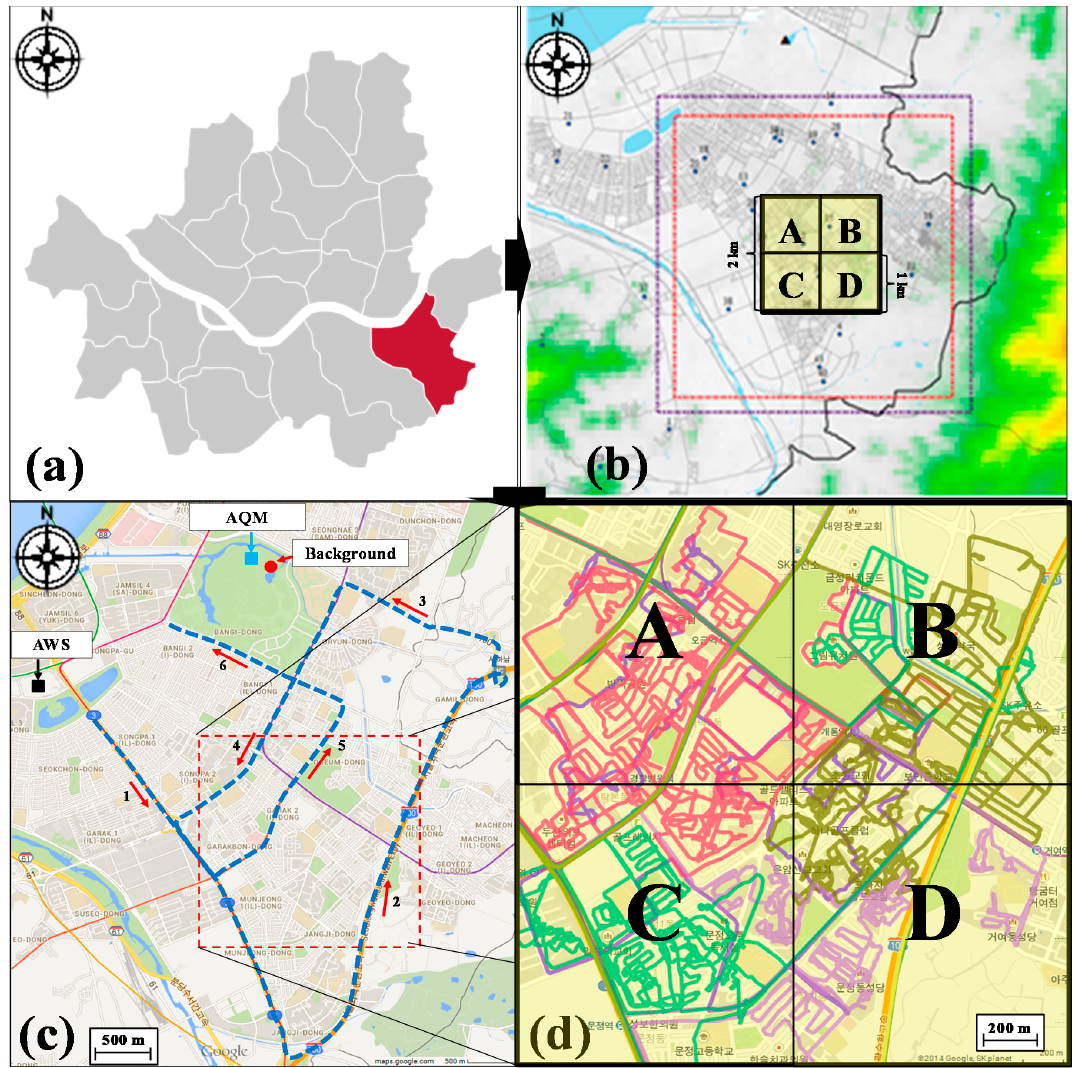
Figure 2. ( a ) Map of Seoul, ( b ) study area, ( c ) common route, and ( d ) 4-day measurement routes with zones A, B, C, and D. The reference location is indicated as a red circle and the common route is shown using blue dotted lines. Detailed traveling routes are presented with different colors for each day.